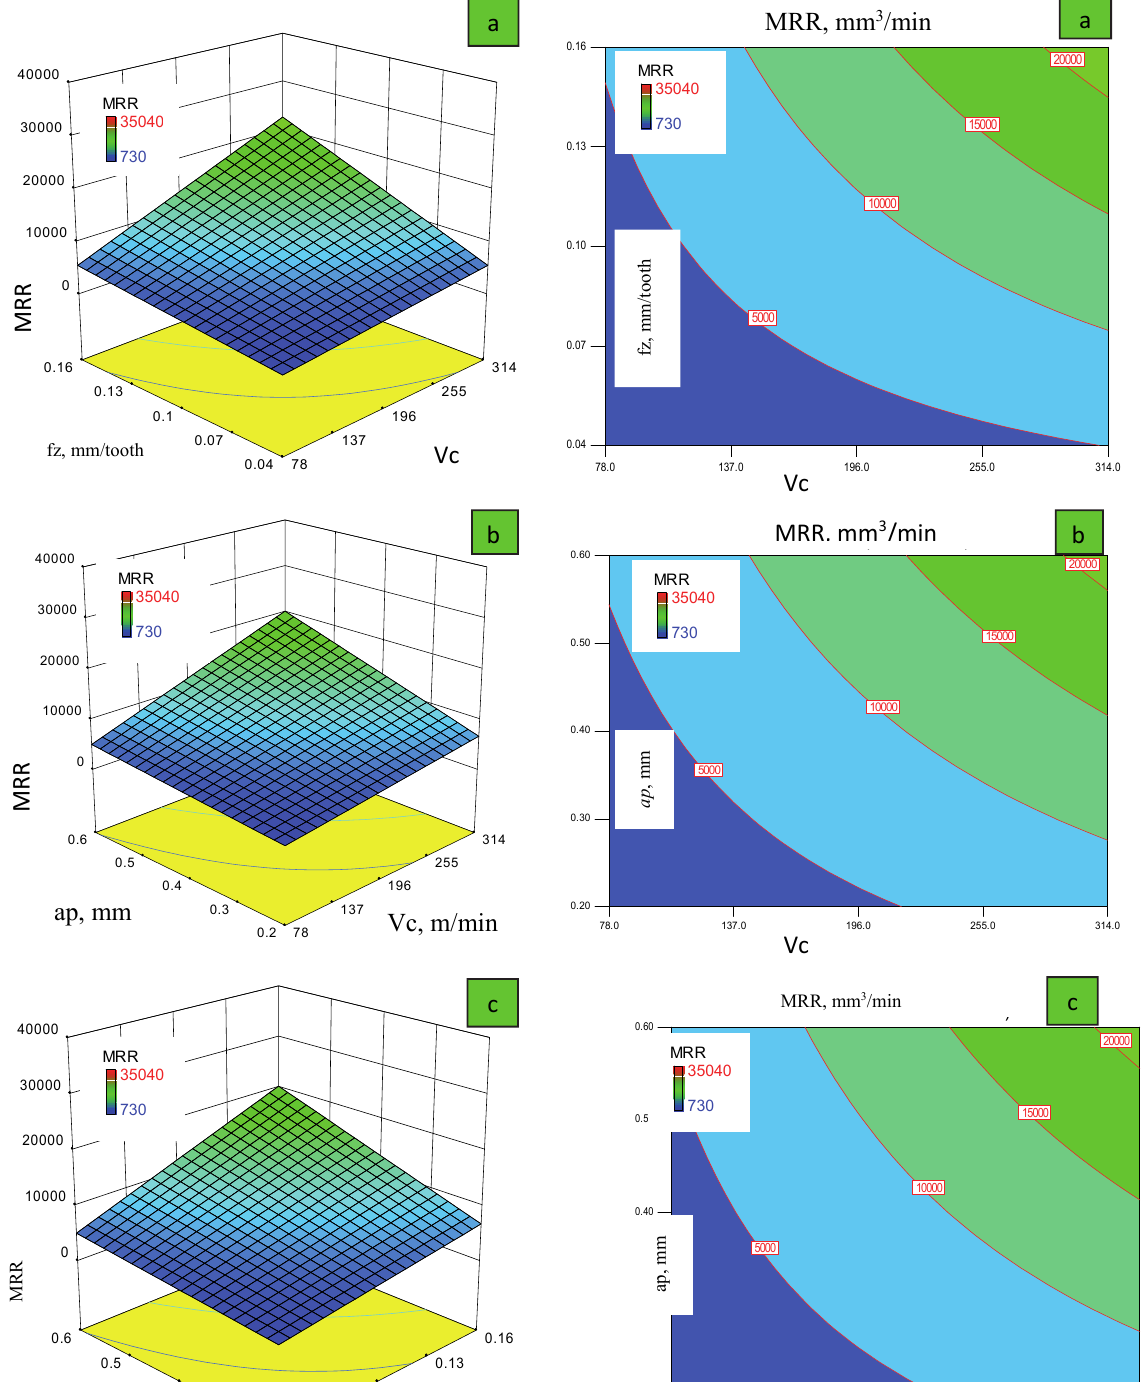
Fig. 8. Response surface for MRR as a function of (Vc, fz), (Vc, ap) and (ap, fz)